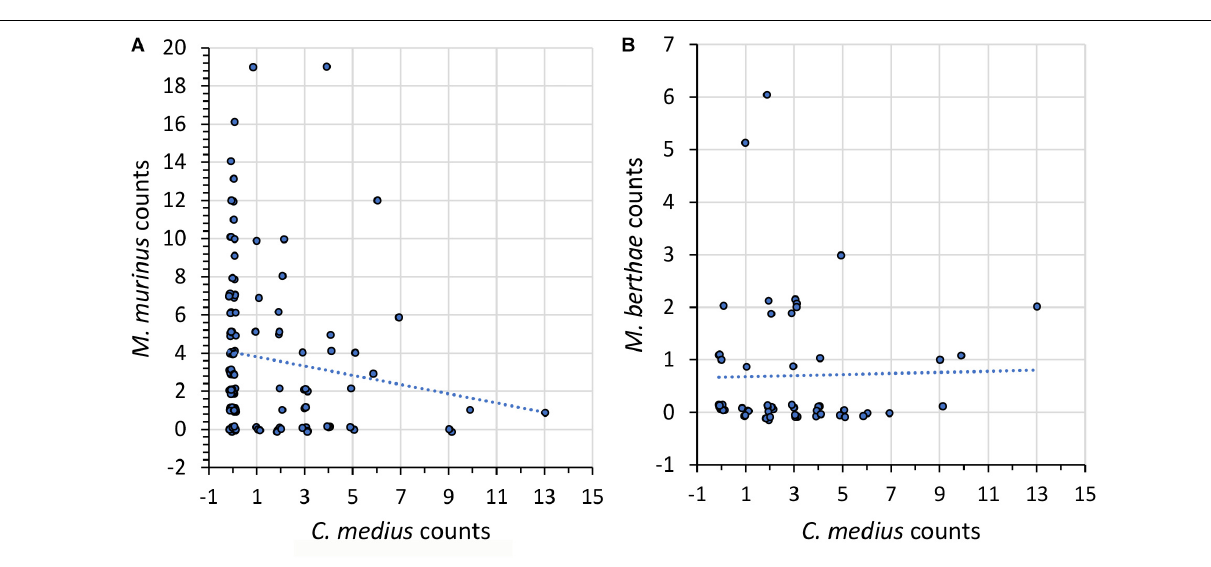
FIGURE 3 | As in Figure 1 but for numbers of sighted (A) M. murinus and (B) M. berthae as a function of the number of C. medius